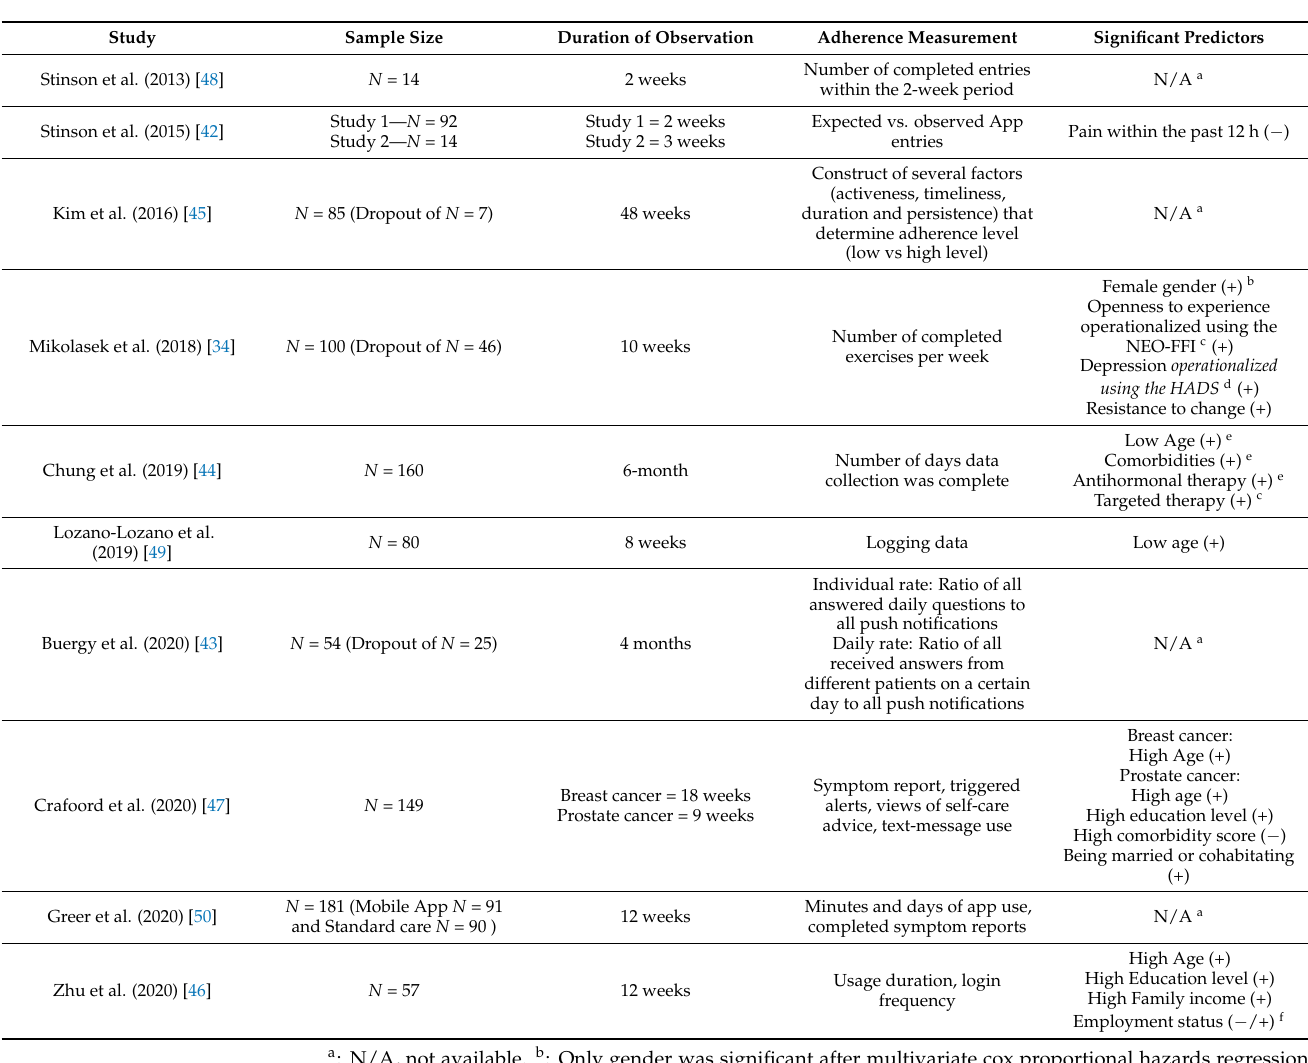
Table 2. Study characteristics, type of the adherence measurement and significant predictors of the included